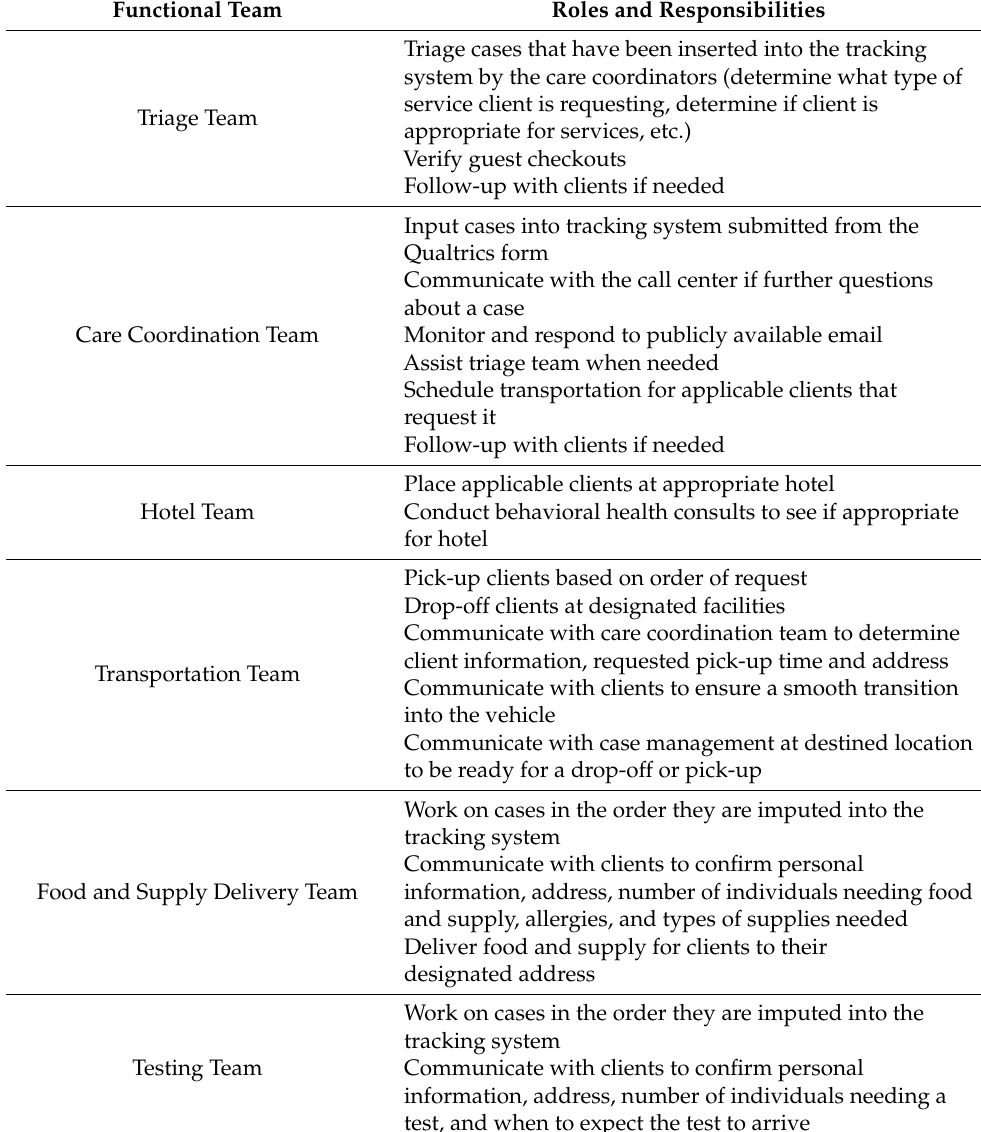
Table 1. Roles and Responsibilities of Key Functional Teams in the Isolation and Quarantine